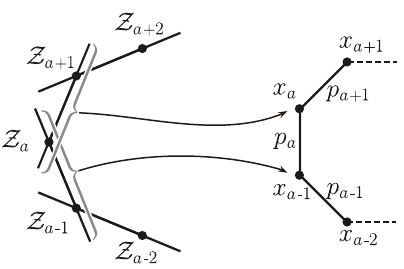
Figure 1 . A representation of the relationship between momenta and momentum twistors, taken from